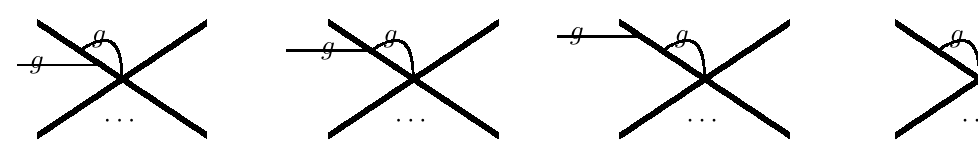
Figure 11 . Diagrams involving 3-graviton vertex.